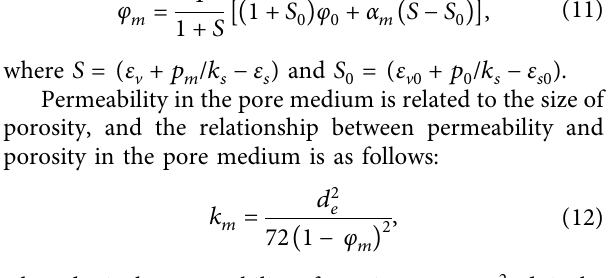
Figure 3: Stress state of a